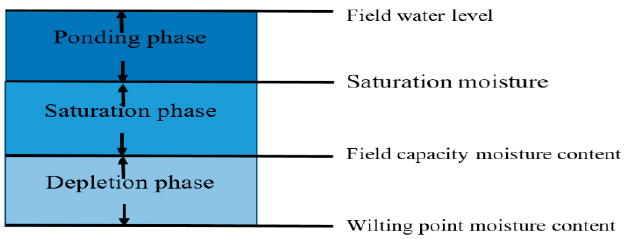
Figure 3. Schematic of the three stages of water balance calculation.